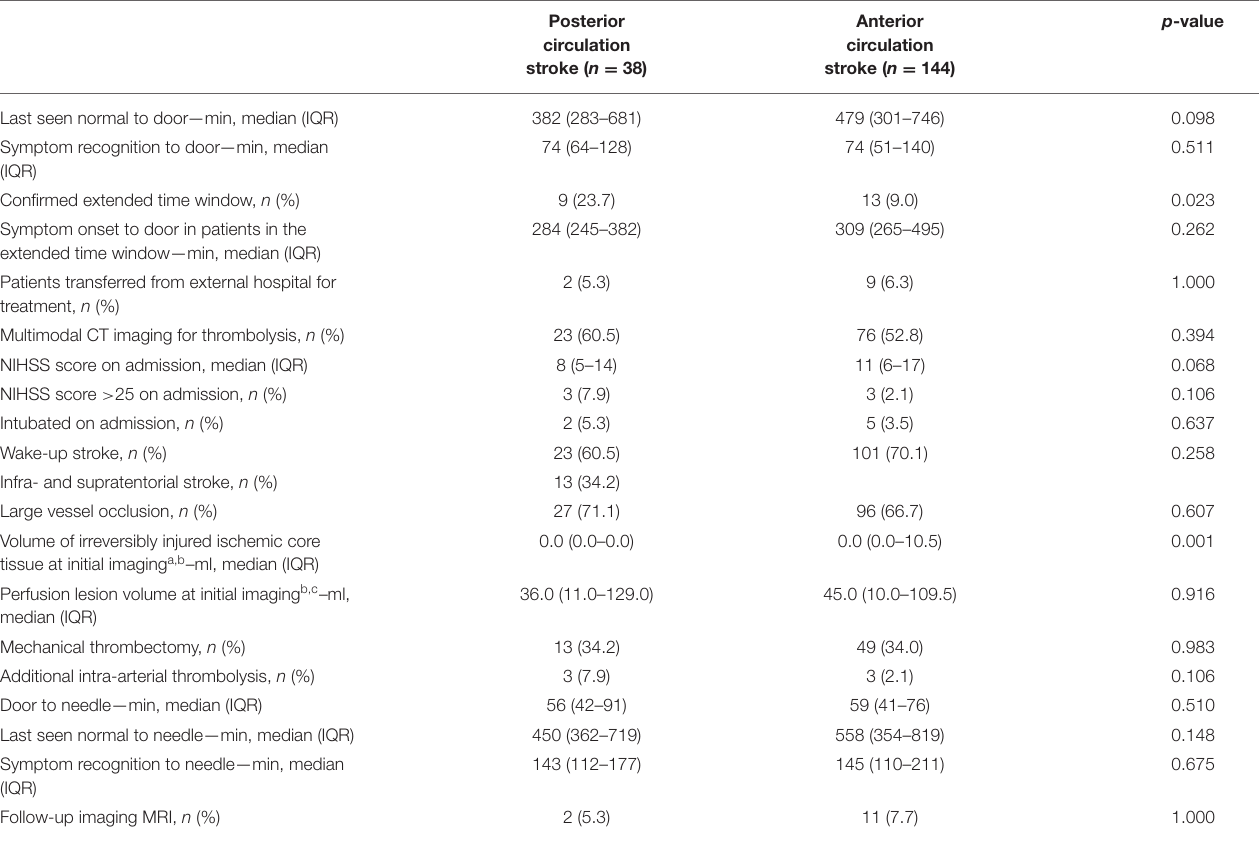
TABLE 2 | Clinical and imaging characteristics of stroke in the clinico-radiological patient cohort.